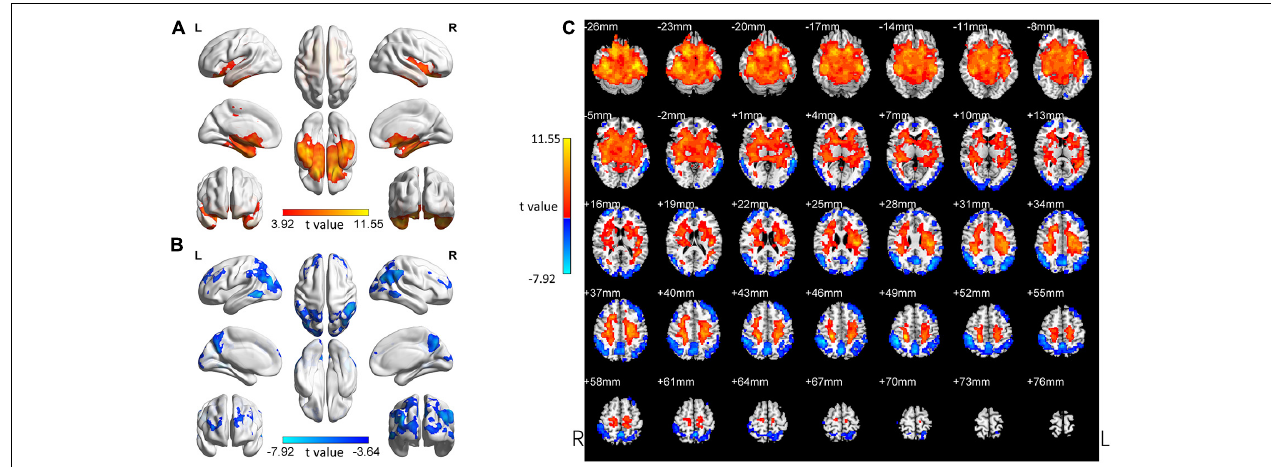
FIGURE 2 | Changed ReHo in the SCD group compared with the HC group. (A) The brain regions with increased ReHo in the SCD group compared with the HC group. (B) The brain regions with decreased ReHo in the SCD group compared with the HC group. (C) Brain regions with increased and decreased ReHo in the SCD group compared with the HC group. Two-tailed t -test; FDR < 0.0005, k > 10 voxels. The color bars indicate t -values, blue color represents negative values and red color represents positive values. L, Left; R,